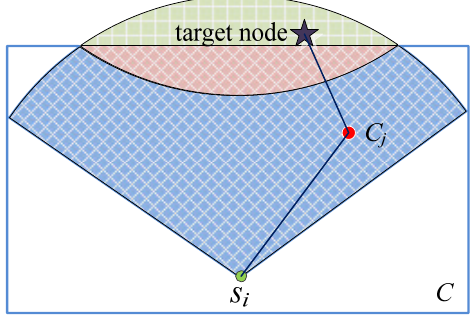
Figure 4. Calculation of network coverage area.